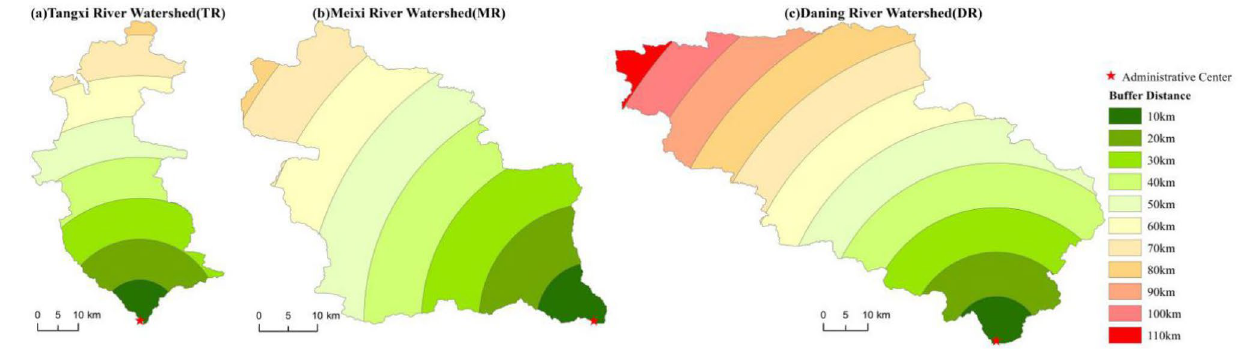
Figure 13. Setting up of watershed buffer zone. Maps were generated using ArcGIS 10.2 for Desktop (http:// www. esri. com/ sofwa re/